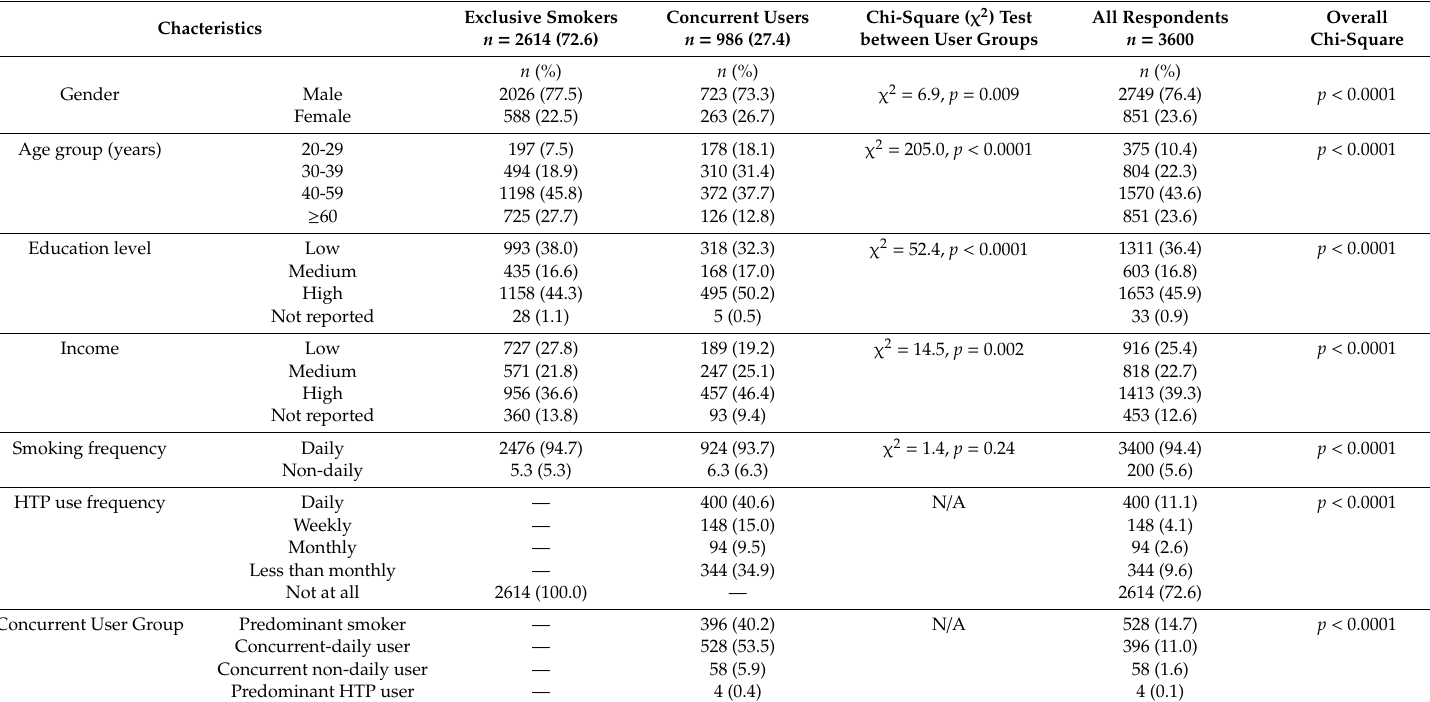
Table 1. Unweighted sample characteristics of respondents at Wave 1